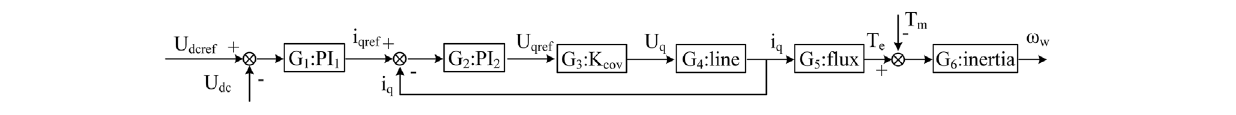
FIGURE 3 | Transfer diagram of the generator-side converter.